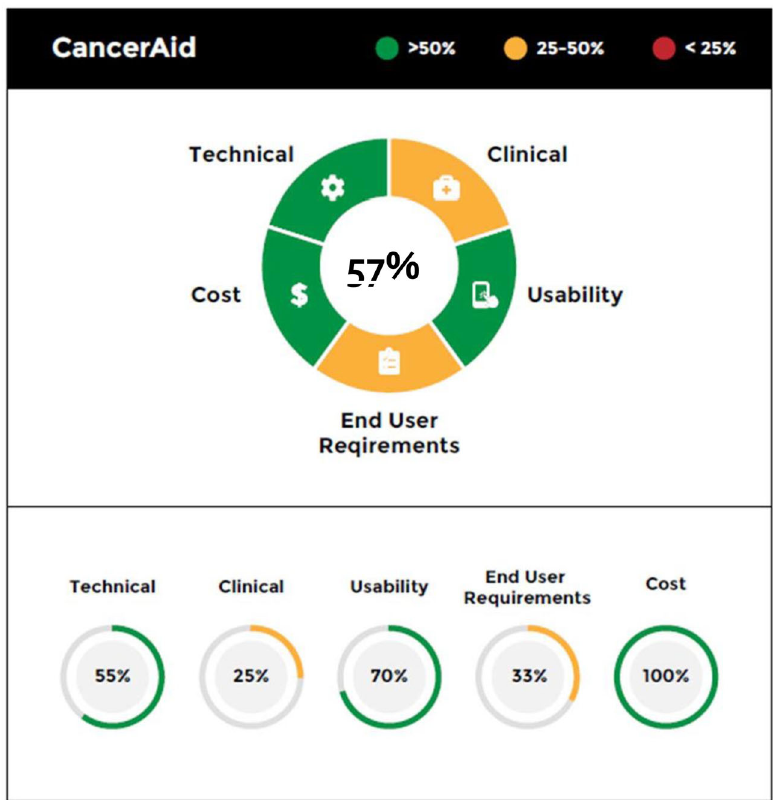
Fig. 5 Digital health scorecard, individual summary. Individual domains are depicted in a segmented wheel and color coded based on performance scores. The overall score for the app is depicted in the center of the segmented wheel.